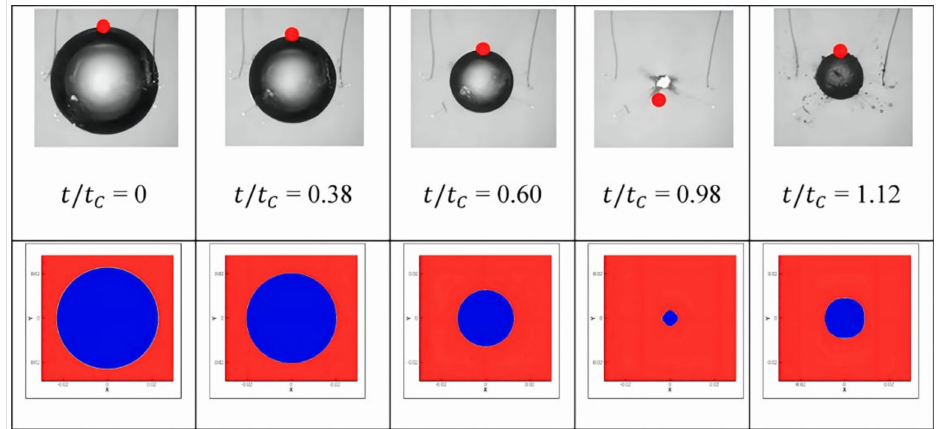
Figure 6. Visual comparison of experimental images and numerical simulation